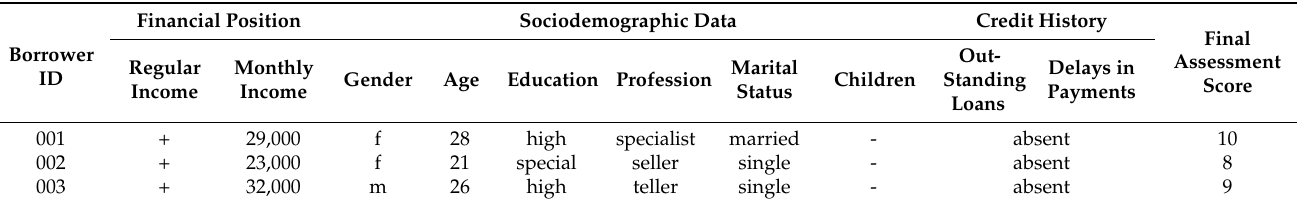
Table 11. Step 2: final credit scoring.